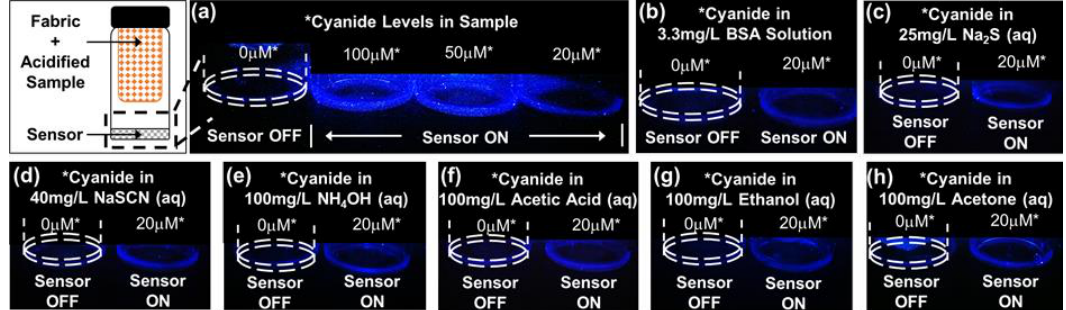
Figure 7. ( a ) Photographs, taken under UV illumination, show that the sensor, located at the bottom of the assay vial, while never in contact with the sample, produces a visually discernible response for samples containing ≥ 20 µ M cyanide. ( b ) Photographs, taken under UV illumination, show that the assay overcomes interference from non-volatile species in the sample as illustrated using BSA solutions. ( c )–( h ) Photographs, taken under UV illumination, show that inclusion of bismuth nitrate in the acidification reagent overcomes sulfide interference and does not produce false positives with other common volatile species expected in biological samples. The acidification reagent comprises 1g / L Bi(NO 3 ) 3 .5H 2 O in 0.55 M H 2 SO 4 . All pictures are taken 30 min after acidification under UV